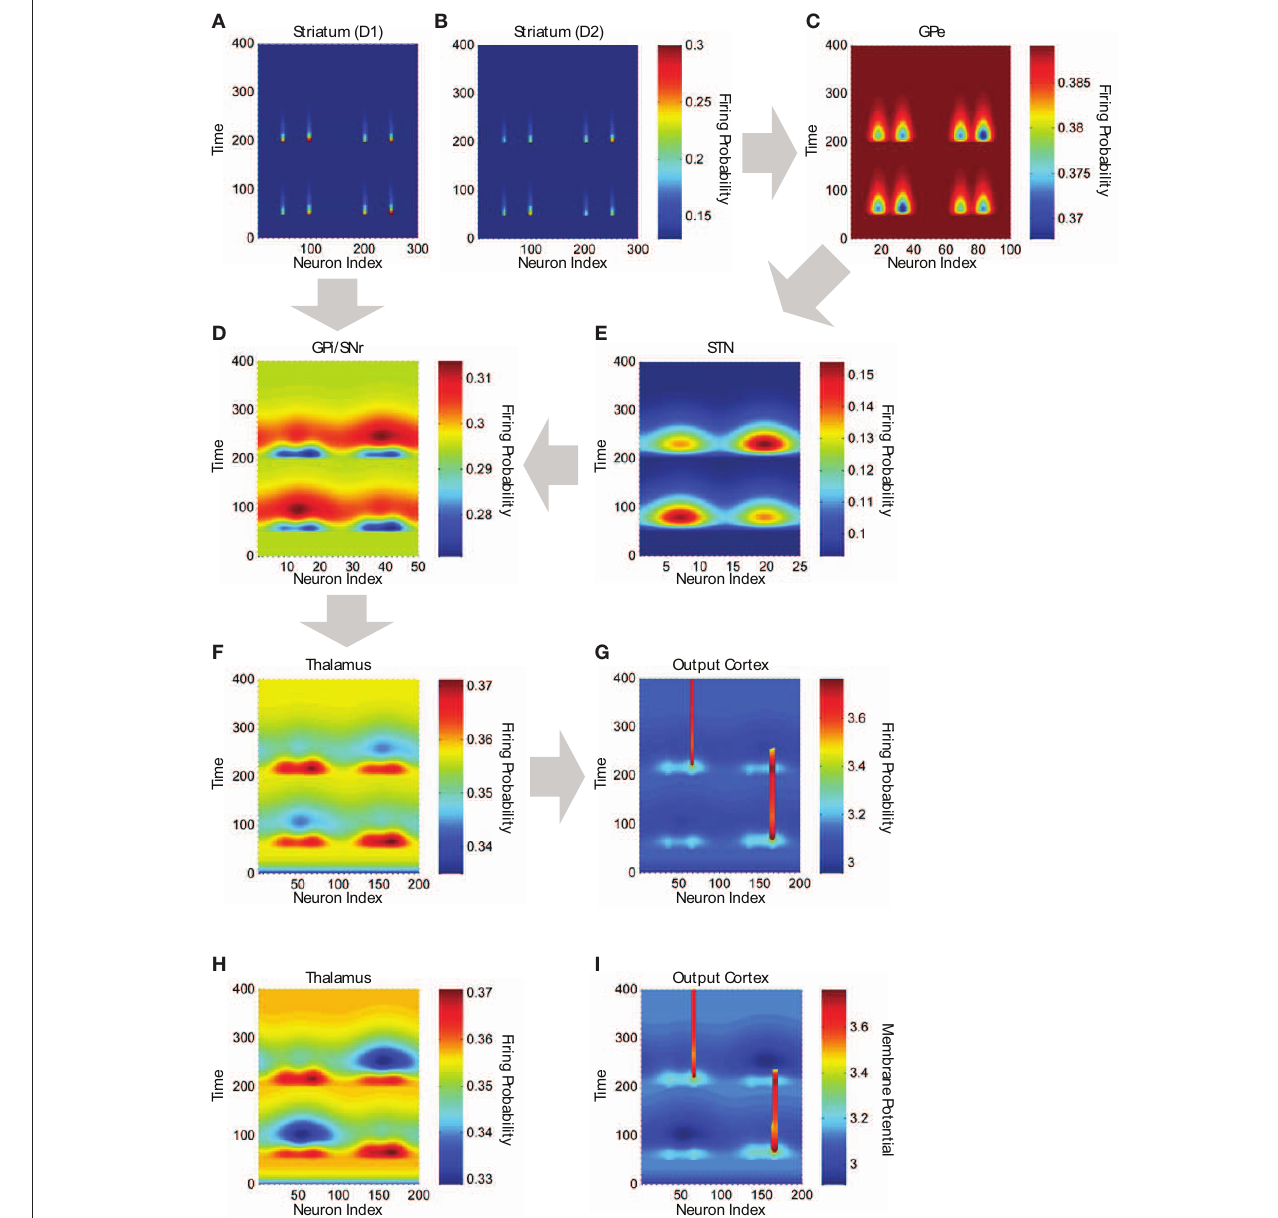
Figure 7 | Neuronal activity in structures of the cortico-basal ganglia- thalamo-cortical network model. (A) Firing frequency of D1 MSNs in the striatum ( n = 300). Color scale indicates firing frequency, x -axis indicates neuron index, and y -axis indicates time in arbitrary units. MSNs on the left (from x = 1 to 150) are in module A and MSNs on the right (from x = 151 to 300) are in module B. Neuron “a” in the input region of the cortex ( Figure 6A , left) projects to MSNs 54 and 205, and neuron “b” projects to MSNs 99 and 249. (B) Firing frequency of D2 MSNs ( n = 300), which receive exactly the same pattern of connections from the input cortex as do D1 MSNs. (C) Firing frequency of GPe neurons ( n = 100). Adjacent GPe neurons receive overlapping convergent inhibitory input from adjacent striatal D2 MSNs. As a result of this overlapping convergent connectivity, the focal striatal activity causes less focal GPe inhibition (i.e., the inhibition is spread or “blurred” over adjacent GPe neurons; blue troughs). (D) Firing frequency of GPi/ SNr neurons ( n = 50), which receive convergent inhibitory input from striatal D1